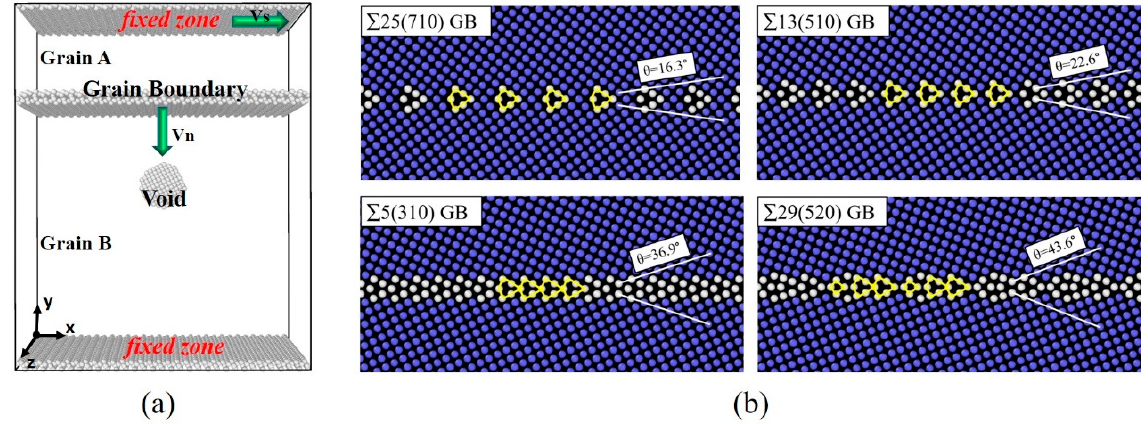
Figure 1. ( a ) Schematic of the bicrystal model used for simulations. ( b ) Atomic images of the equilibrium structure of Σ 25(710) ( θ = 16.3 ◦ ) GB, Σ 13(510) ( θ = 22.6 ◦ ) GB, Σ 5(310) ( θ = 36.9 ◦ ) GB, and Σ 29(520) ( θ = 43.6 ◦ ) GB. The GB structures are colored according to the common neighbor analysis (CNA) parameter. The structural units are outlined by the yellow lines.